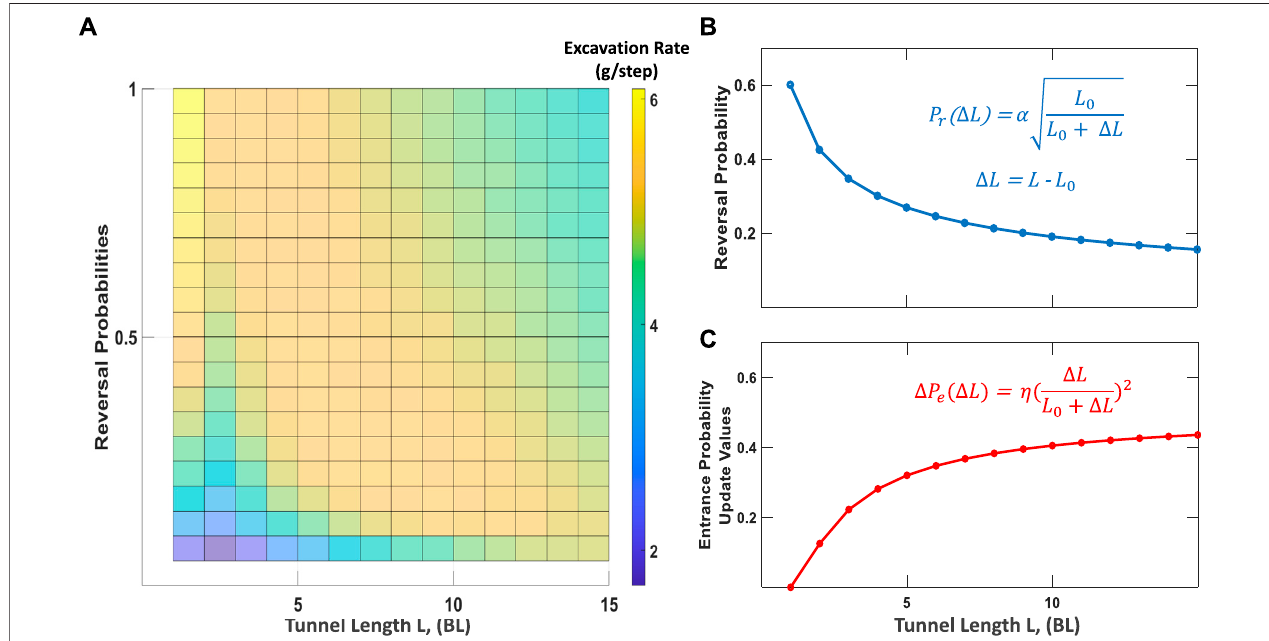
FIGURE3 | Probability sweep over tunnel length with selected equation models. (A) Reversal probability sweep vs. Tunnel length. Plot shows that high to medium reversal probabilities give the highest excavation rate for short tunnels, while low reversal probabilities give the highest excavation rates for long tunnels (B) Selected equationformodellingReversalprobabilitiesasafunctionoftunnellengthformulti-robotexperiments (C) LearningupdatevalueforEntranceprobabilitiesasafunctionof tunnel length for multi-robot experiments.